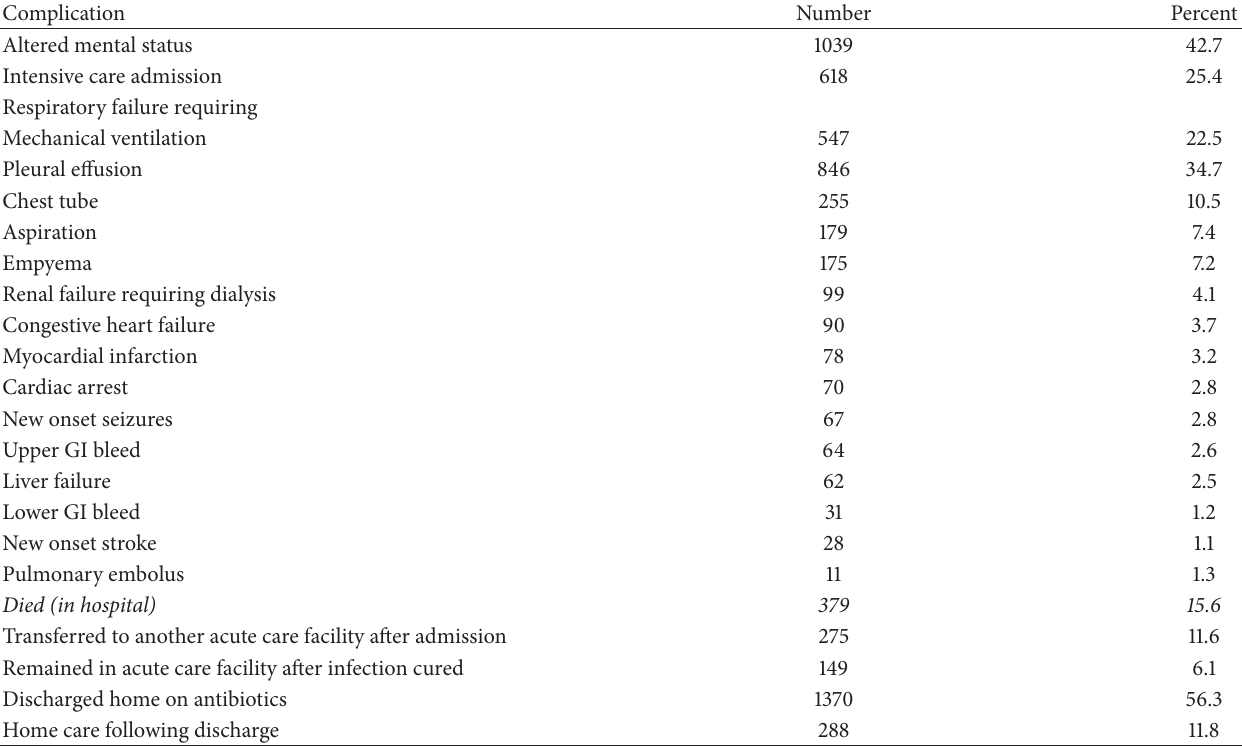
Table 5: Complications/outcomes of invasive pneumococcal disease among 2435 patients.